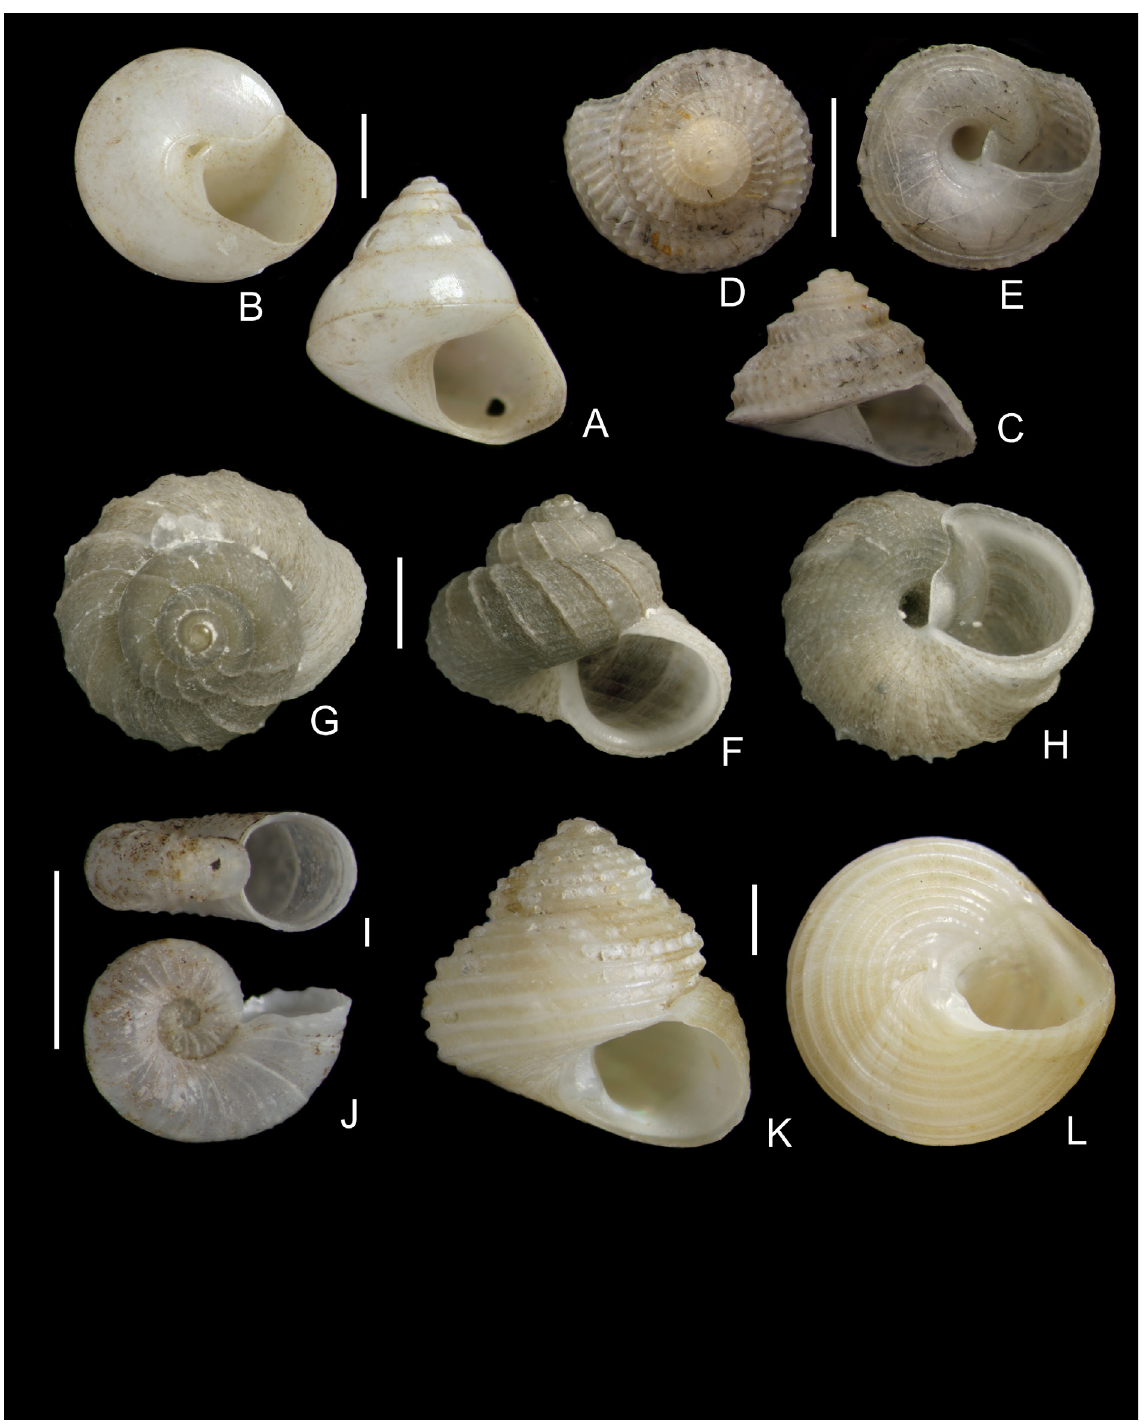
Fig. 13. Seguenzioidea and Colloniidae. A–B . Asthelys munda (Watson, 1879), BANGAL 0711, DR15, 1410 m, 3.2 mm. C–E . Basilissopsis watsoni Dautzenberg & H. Fischer, 1897, BANGAL 0711, DR12, 1585 m, 1.8 mm. F–H . Vetulonia paucivaricosa (Dautzenberg, 1889), BANGAL 0711, V6, 909 m, diameter 3.3 mm. I–J . Adeuomphalus sinuosus (Sykes, 1925), BANGAL 0711, DR12, 1585 m, diameter 1.5 mm. K–L . Cantrainea globuloides (Dautzenberg & H. Fischer, 1896), SEAMOUNT 1, DW116, 985–1000 m, 4.7 mm. Scale bars = 1